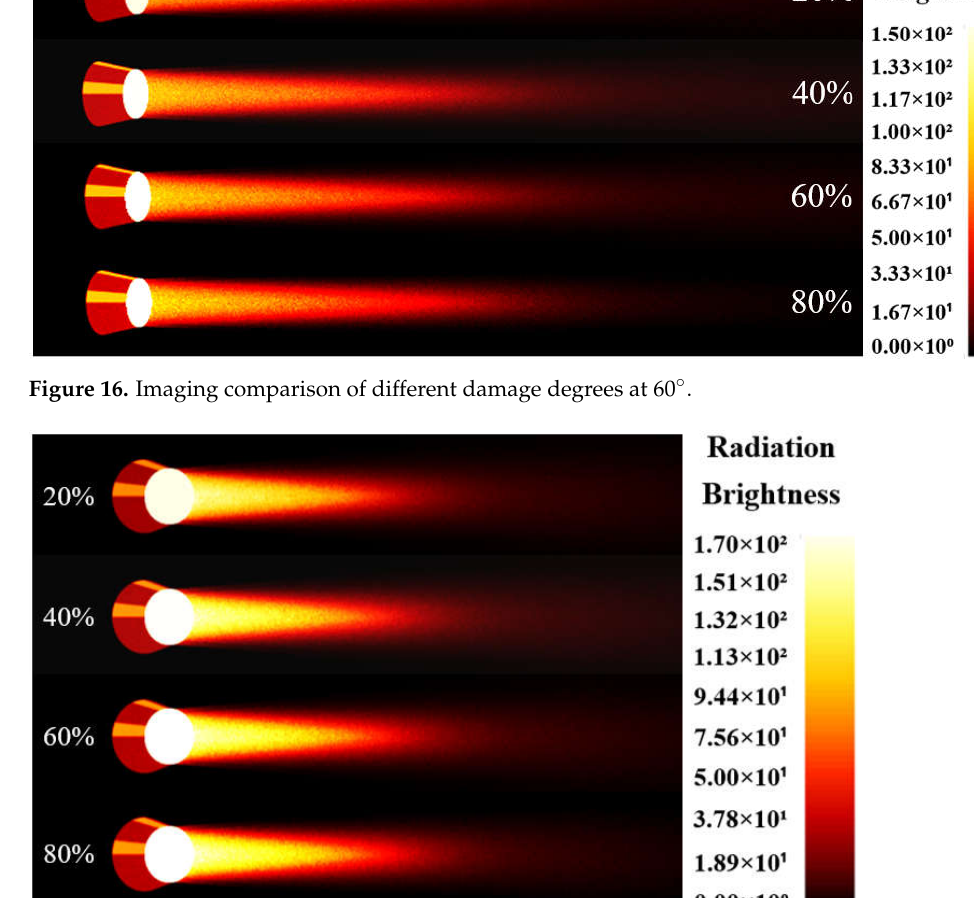
Figure 18. Imaging comparison of different damage degrees at 0°.